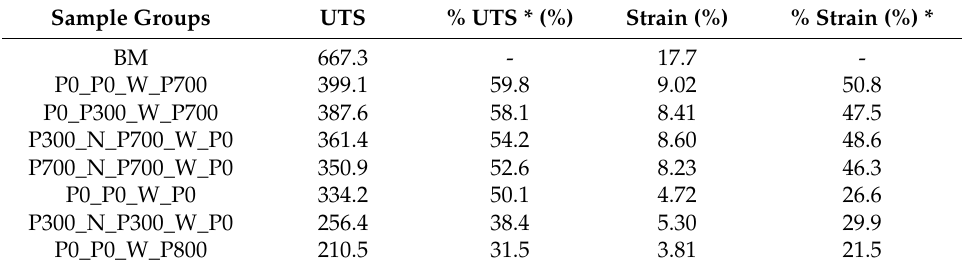
Table 5. Percentage of average UTS and strain in comparison with tested reference values of BM.